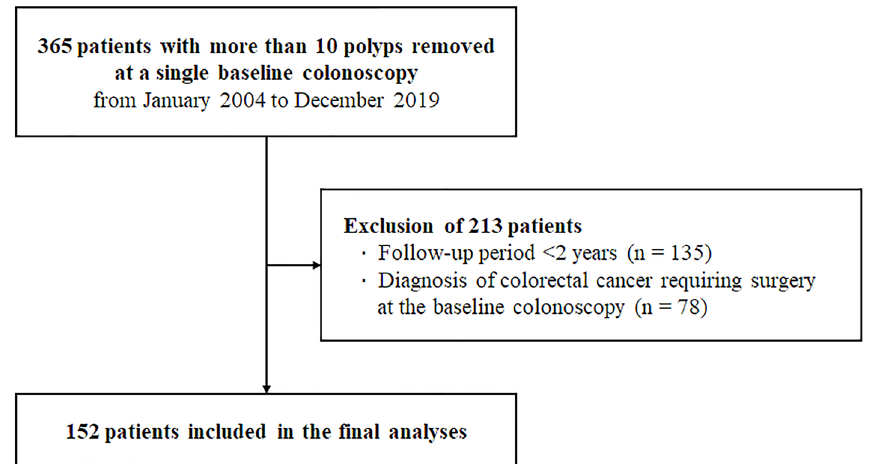
Figure 2. Flow chart for inclusion of